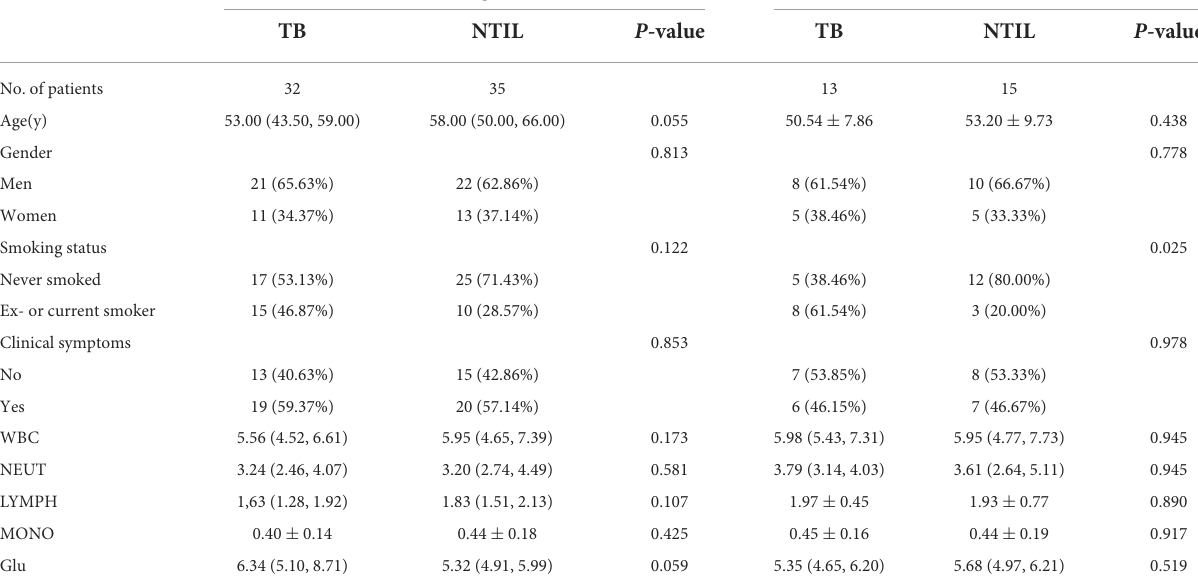
TABLE 1 Clinical information of the